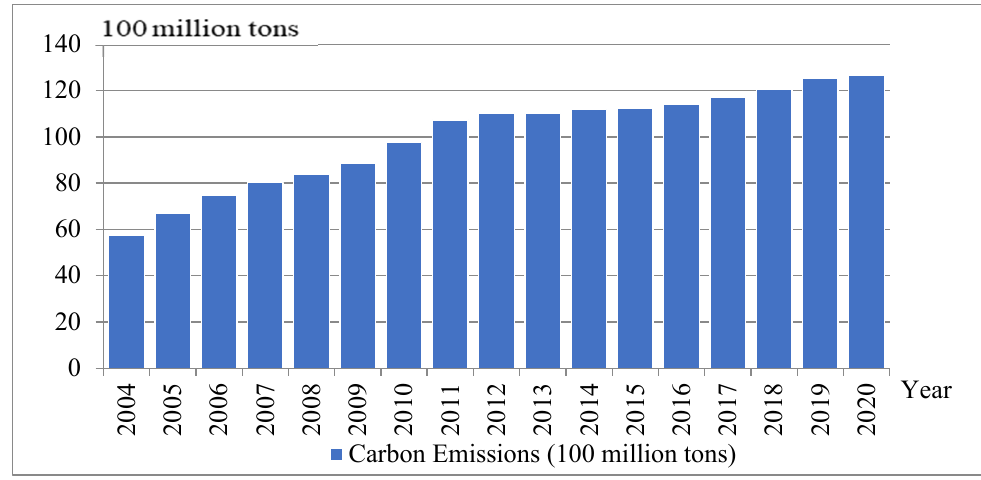
Figure 1. China’s carbon emissions from 2004 to 2020.